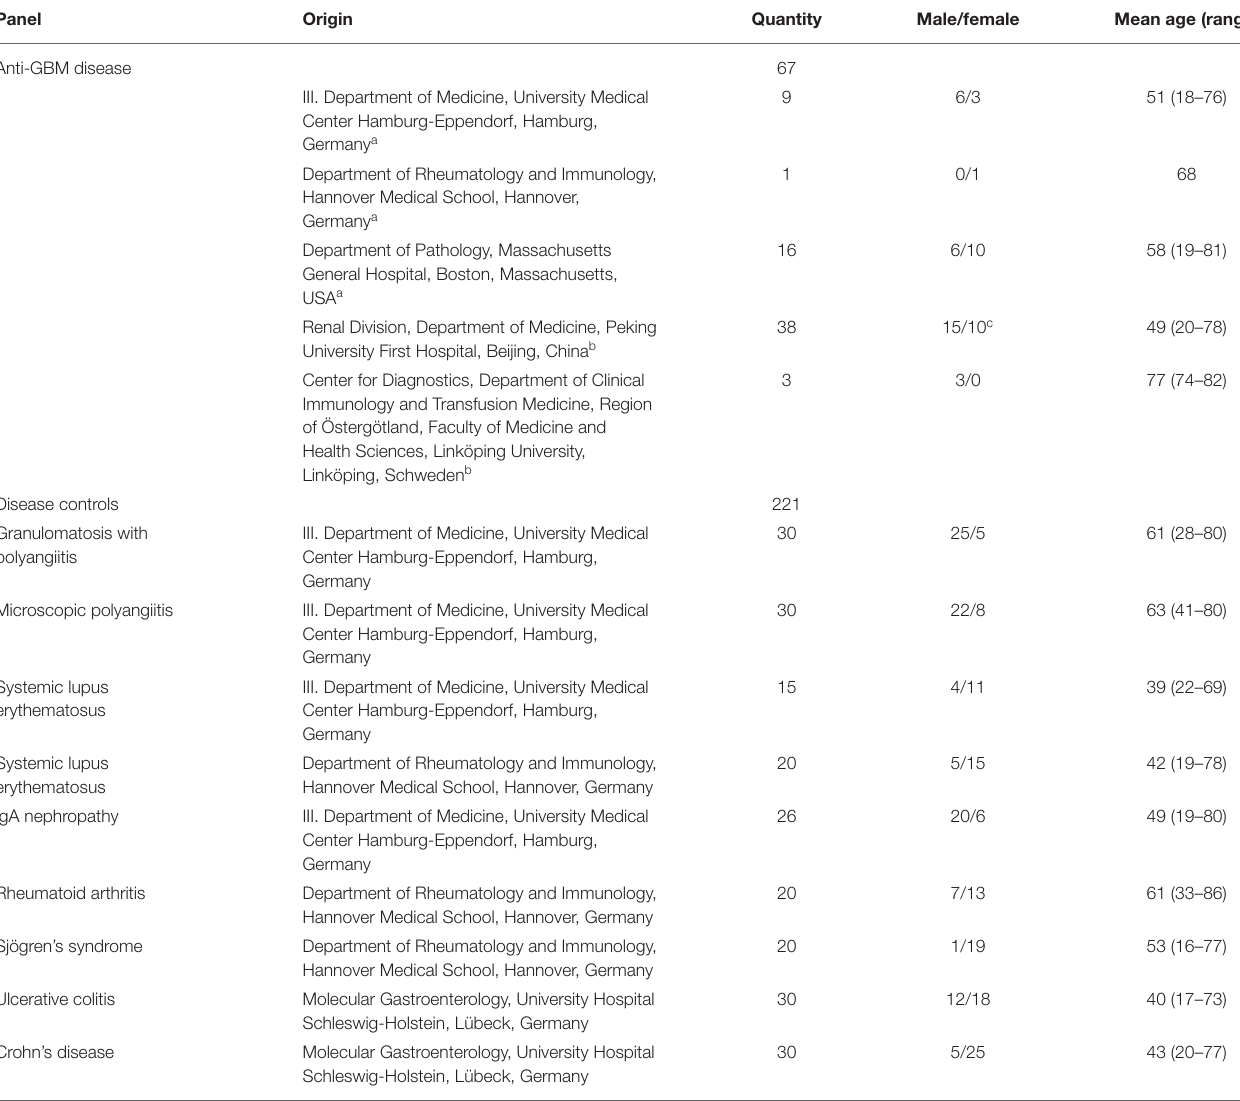
TABLE 1 | Patient characteristics. Panel